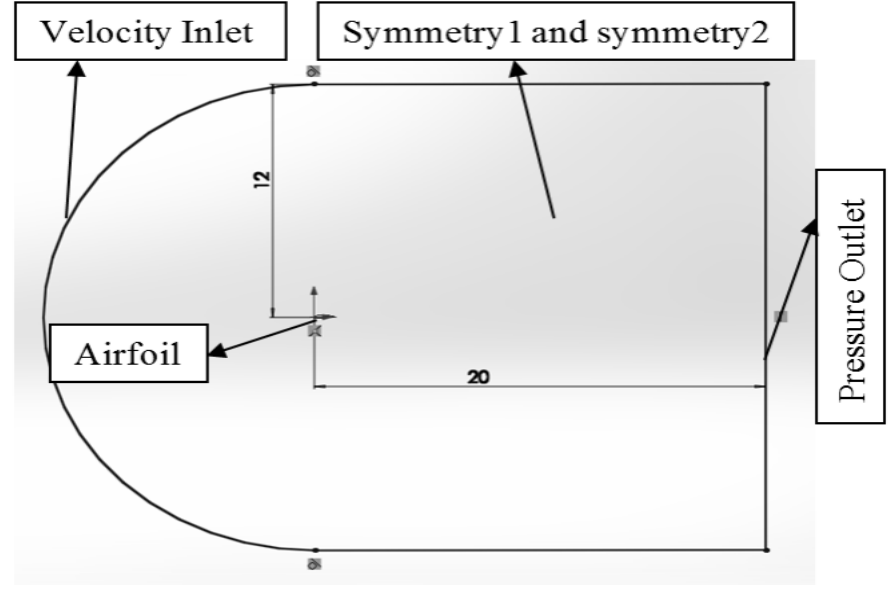
Figure 2. Boundary zone for airfoil.